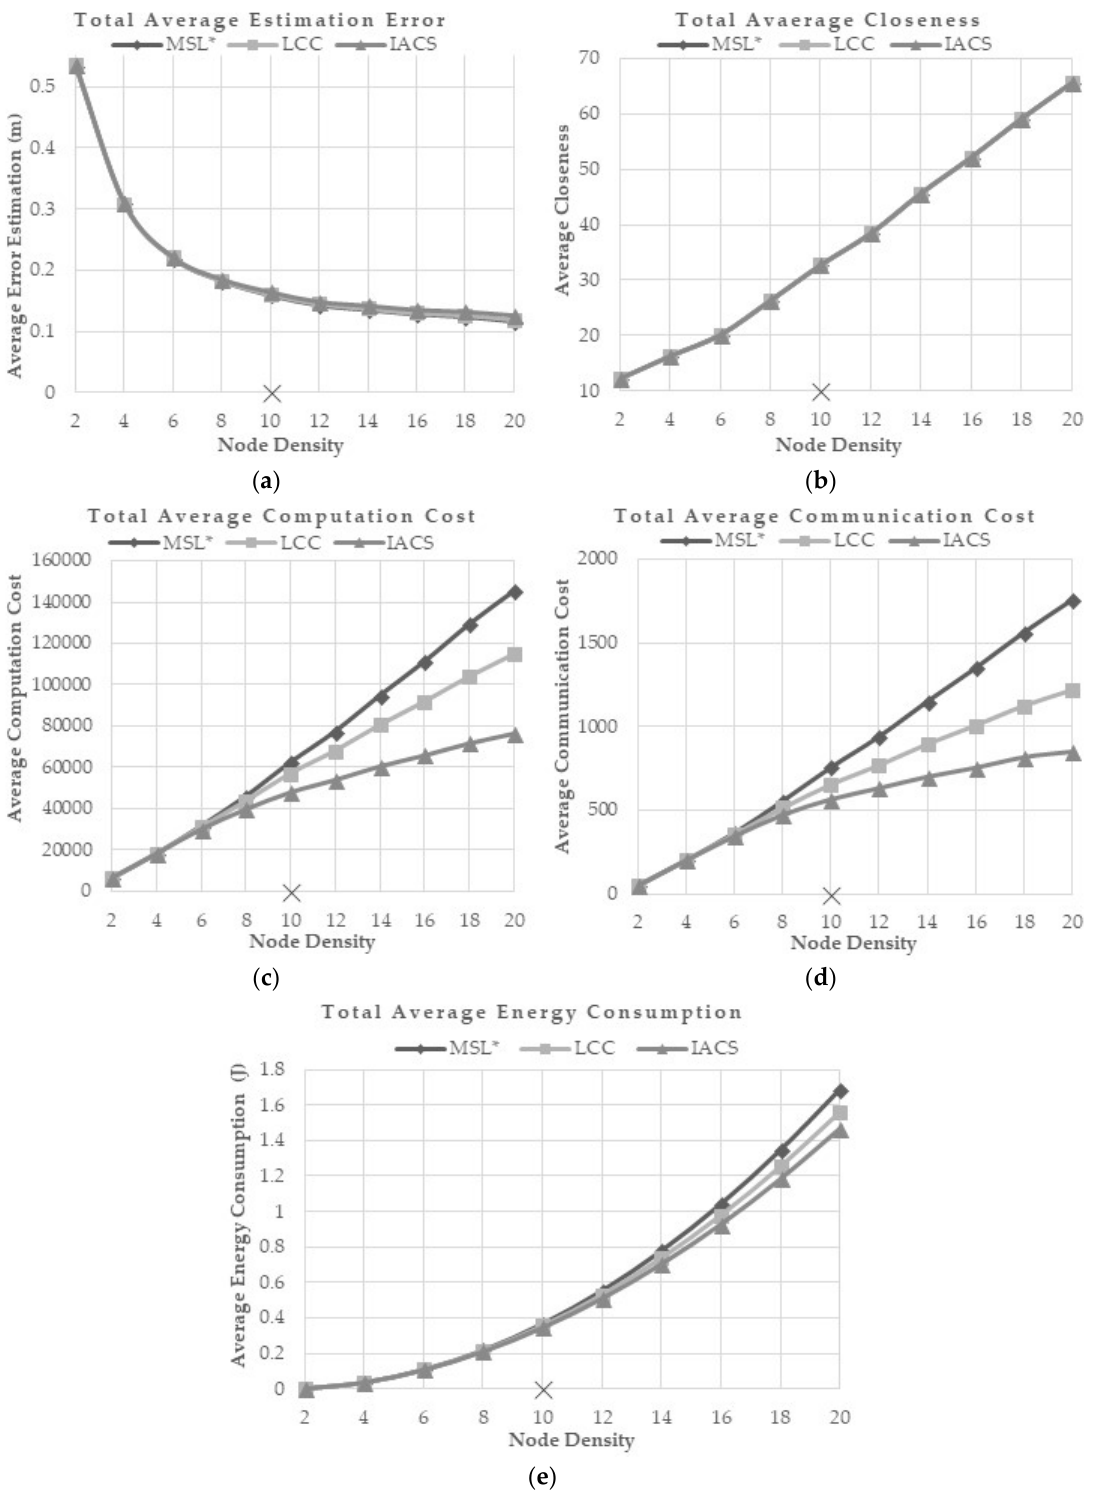
Figure 10 . ( a ) Total Average Estimation Error, ( b ) Total Average Closeness, ( c ) Total Average Computation Cost, ( d ) Total Average Communication Cost, and ( e ) Total Average Energy Consumption for Different Node Density.